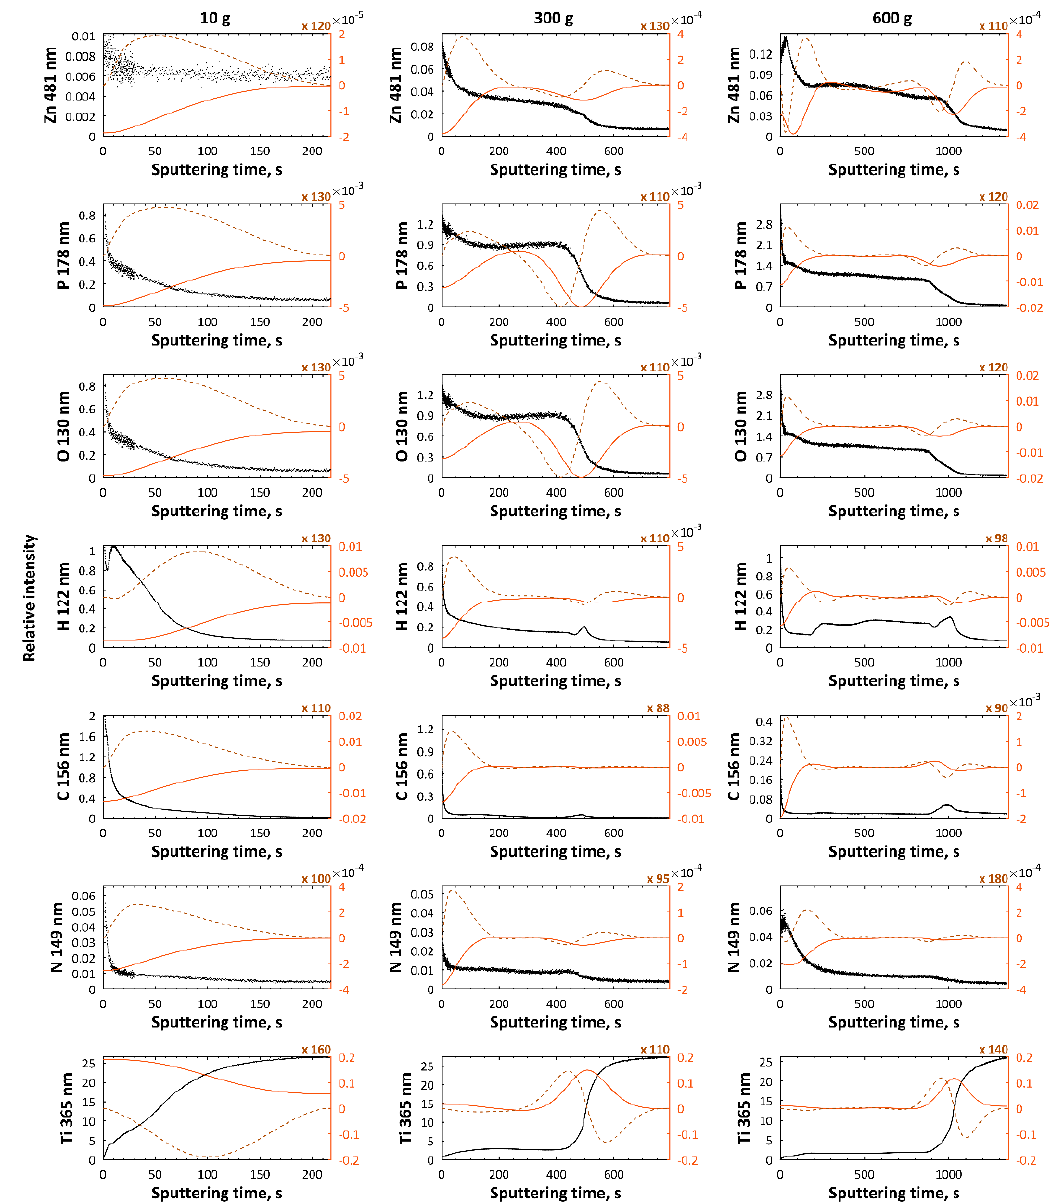
Figure 5. GDEOS signals (black) with first (red continuous line) and second (brown dashed line) derivatives for samples after PEO processing obtained in electrolyte composed of Zn(NO 3 ) 2 ·6H 2 O in H 3 PO 4 at concentrations of 10 g/L, 300 g/L, and 600 g/L at a voltage of 450 ± 46 V, with a pulsation frequency of 300 Hz.